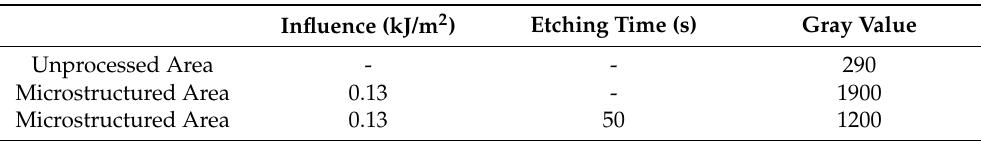
Figure 4. ( a ) Photograph of microstructured CMOS image sensor, microstructured area are marked with a red dashed line. ( b , c ) Gray value measurements of microstructured area and unprocessed area on the surface of microstructured CMOS image sensor at different integration times: ( b ) 4 ms; ( c ) 100 ms. ( d ) NIR absorption spectra of microstructured area of CMOS image sensor before and after short-time etching. The NIR absorptance of an untreated normal area of CMOS image sensor is included for comparison. ( e ) Quantum efficiency ratio versus wavelength for microstructured CMOS image sensor before and after short-time etching. The ratio of an untreated commercial silicon CMOS image sensor is included for reference. Table 2. Gray value measurements of microstructured area and unprocessed area of CMOS image sensor at an integration time of 100 ms.